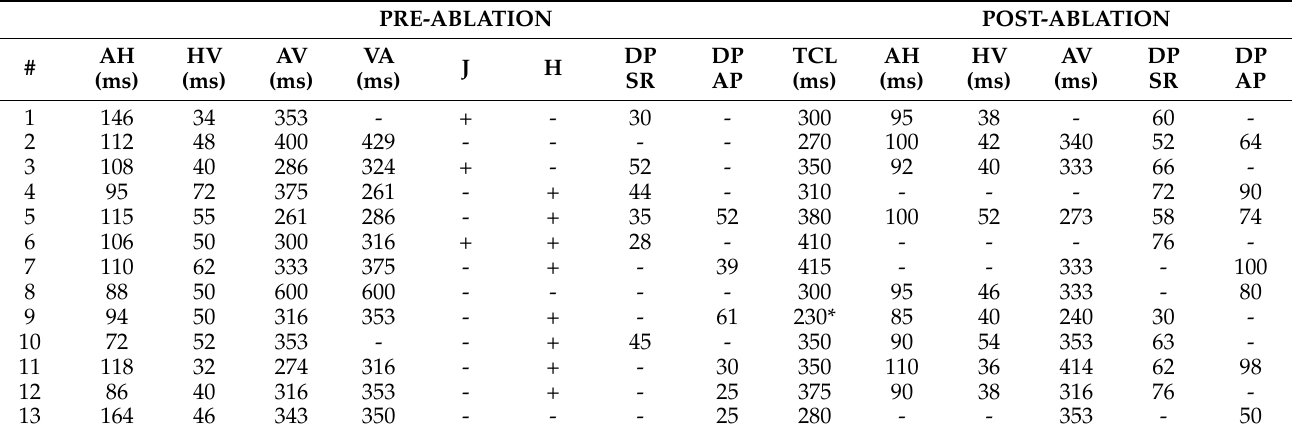
Table 2. Electrophysiological